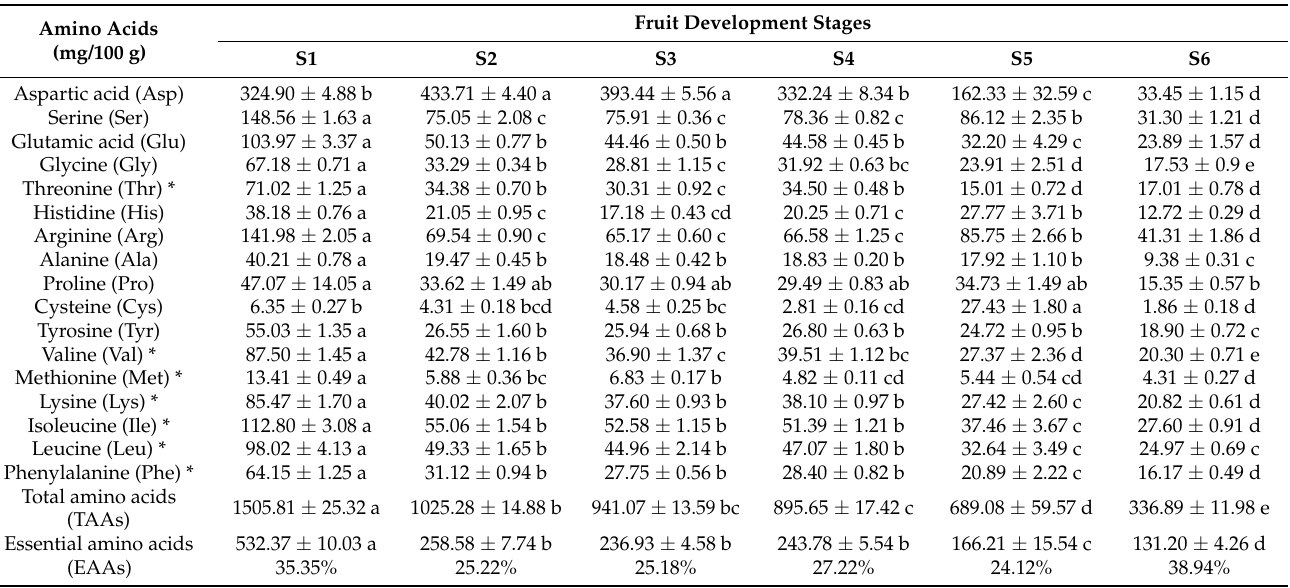
Table 4. Dynamic changes of amino acid composition during S. obovatifoliola subsp. urophylla fruit